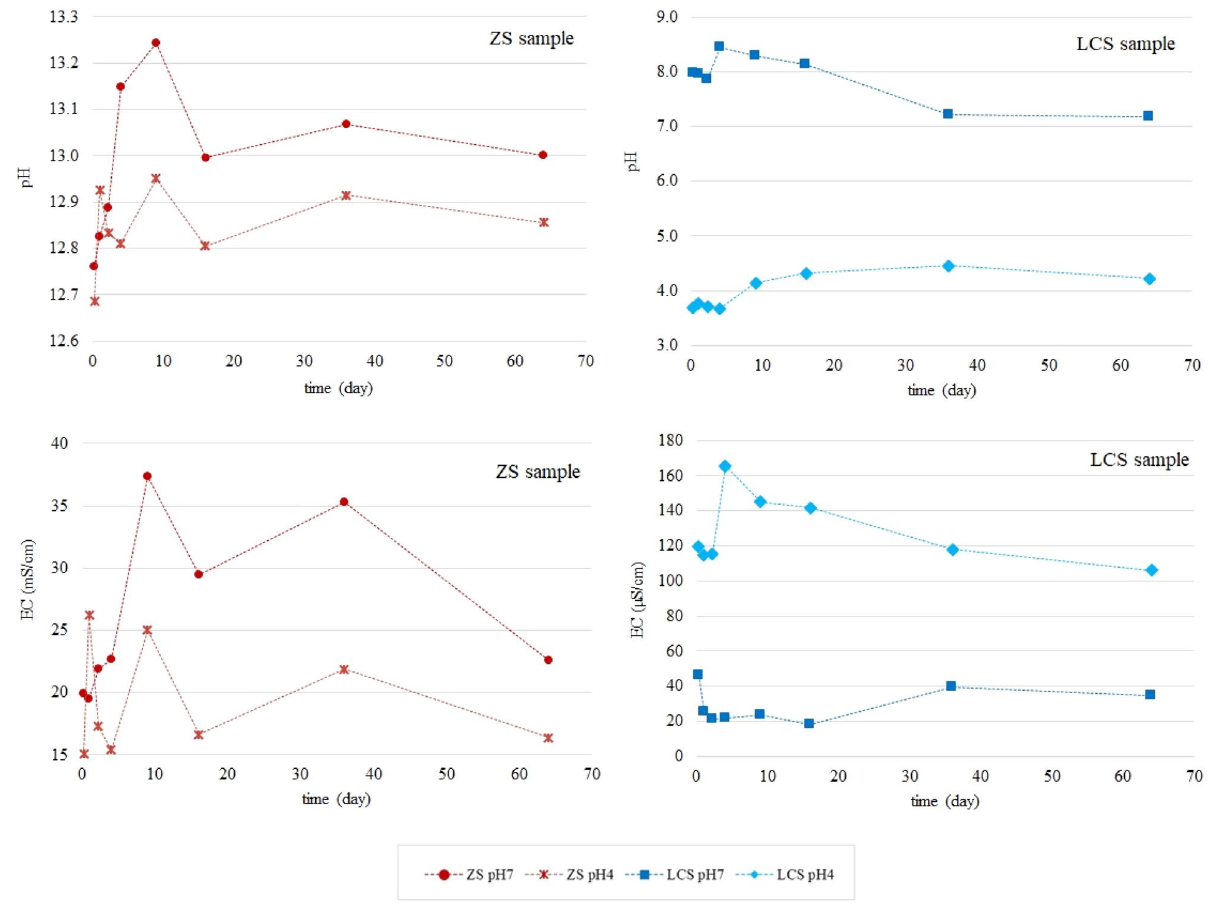
Figure 2. Changes in pH and EC of eluates extracted during 64 days of the tank